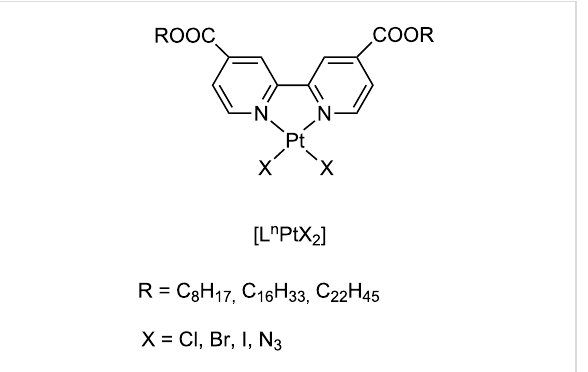
Figure 5: Molecular structure of Zn(II) complexes based on poly- catenar 4,4′-disubstituted